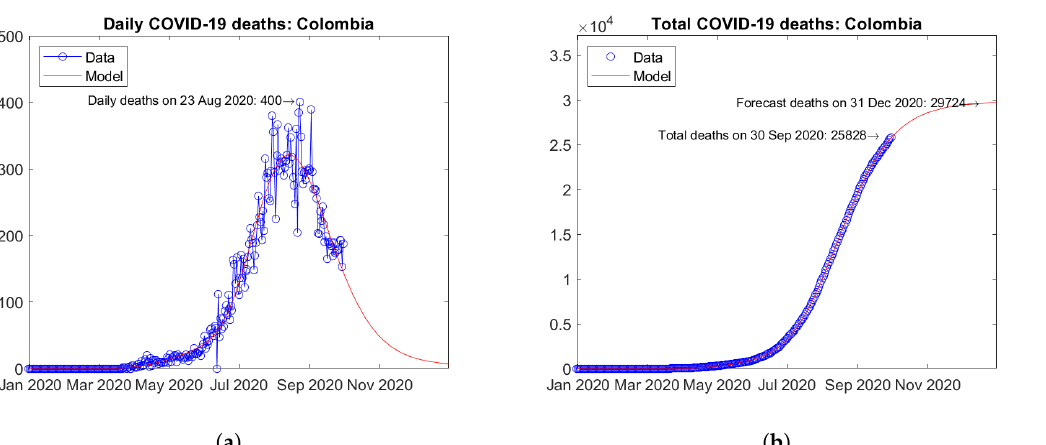
Figure 22. Actual and predicted trends in Peru: ( a ) daily deaths, ( b ) total deaths.